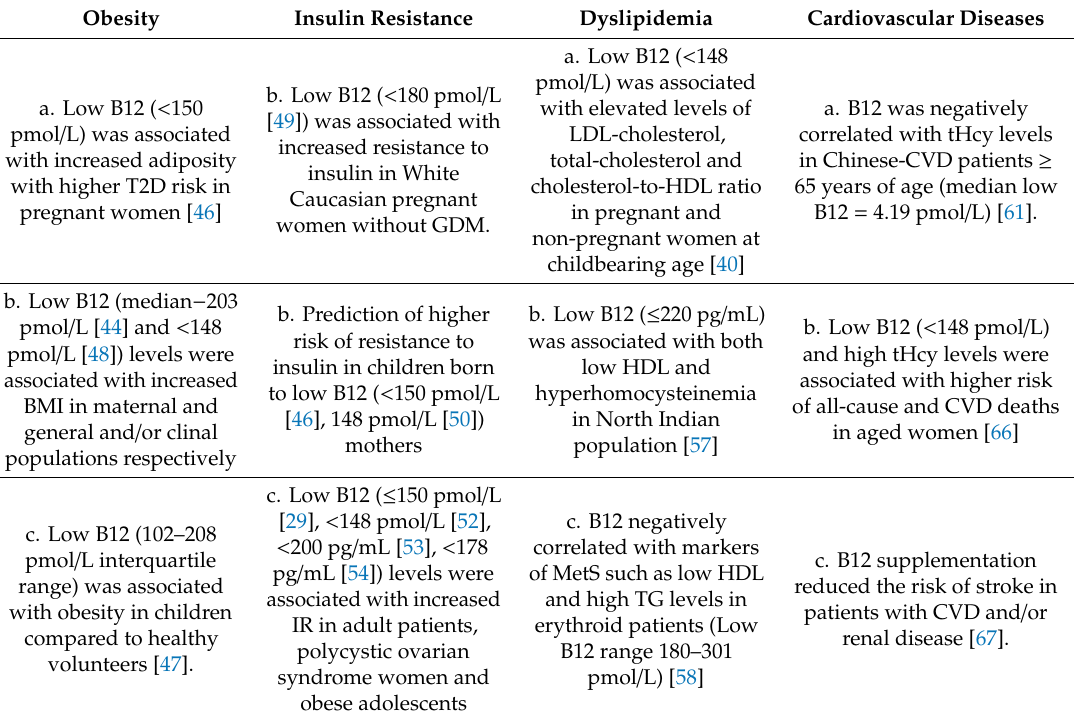
Table 3. The e ff ect of low B12 on components of cardiometabolic risk in clinical